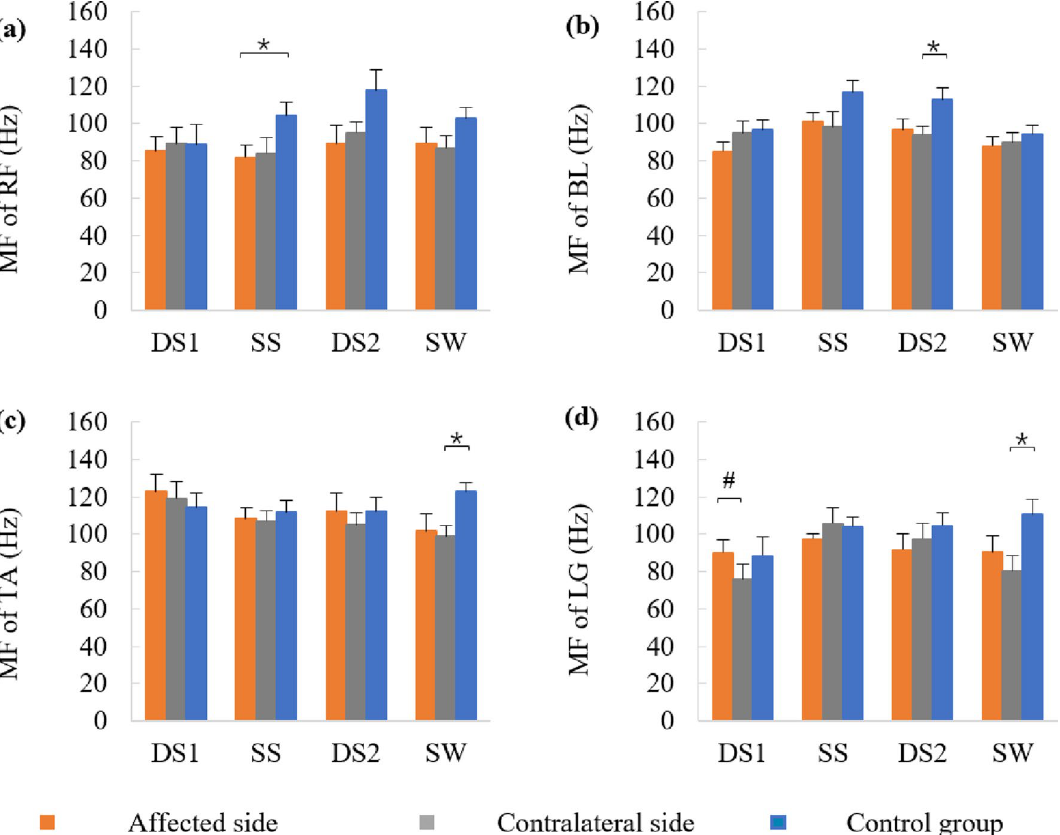
Figure 4. The mean frequency (MF) of surface electromyography (SEMG) in ( a ) rectus femoris (RF), ( b ) biceps femoris long head (BL), ( c ) tibialis anterior (TA), and ( d ) lateral gastrocnemius (LG) muscles during the first